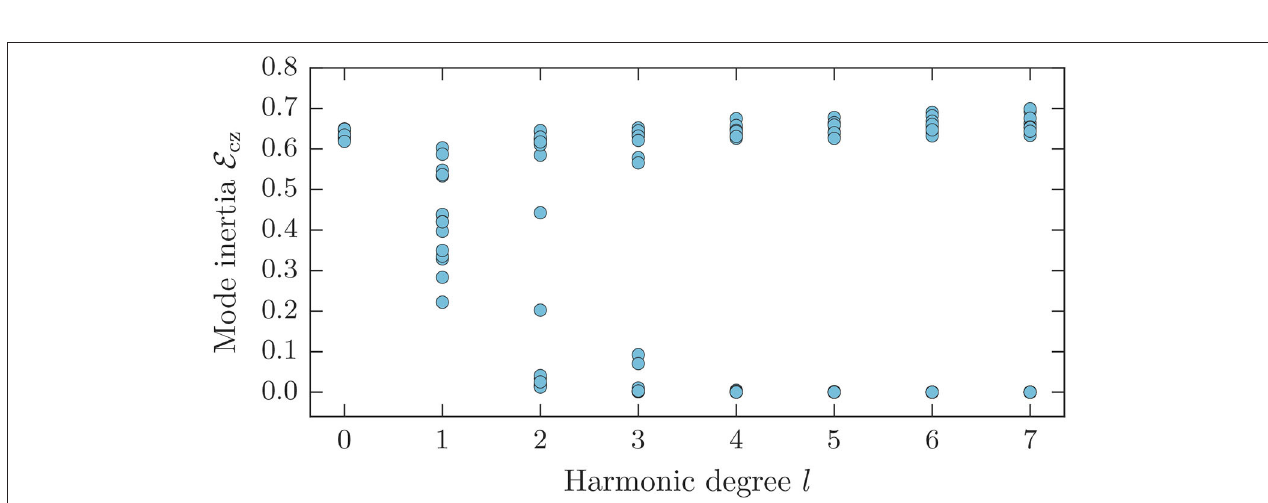
FIGURE 1 | Mode inertia in the convection zone of the subgiant for modes of harmonic degree l 400 900 µ −